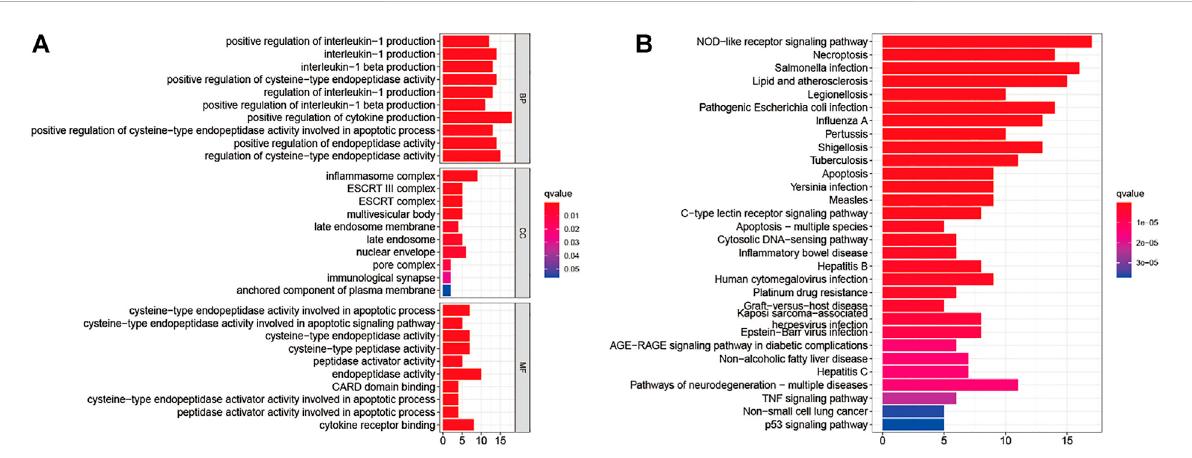
FIGURE 2 Gene Ontology (A) and The Kyoto Encyclopedia of Genes and Genomes (B) Enrichment analyses for nasopharyngeal carcinoma-related pyroptosis-associated